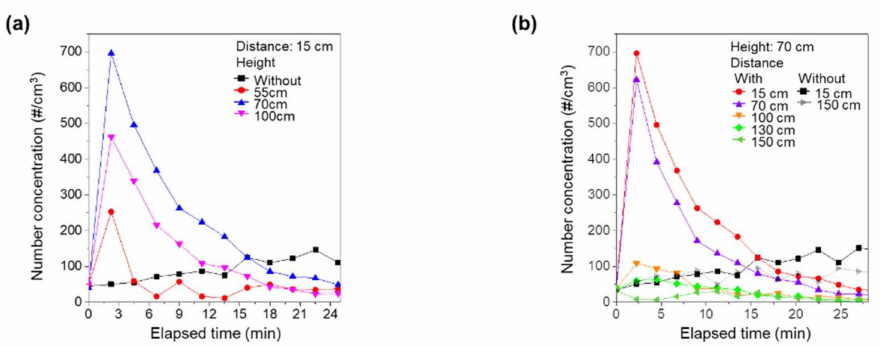
Figure 3. Change in the concentration of nano-sized aggregates as a function of time ( a ) for various heights of source and ( b ) for various distances between the air purifier and the